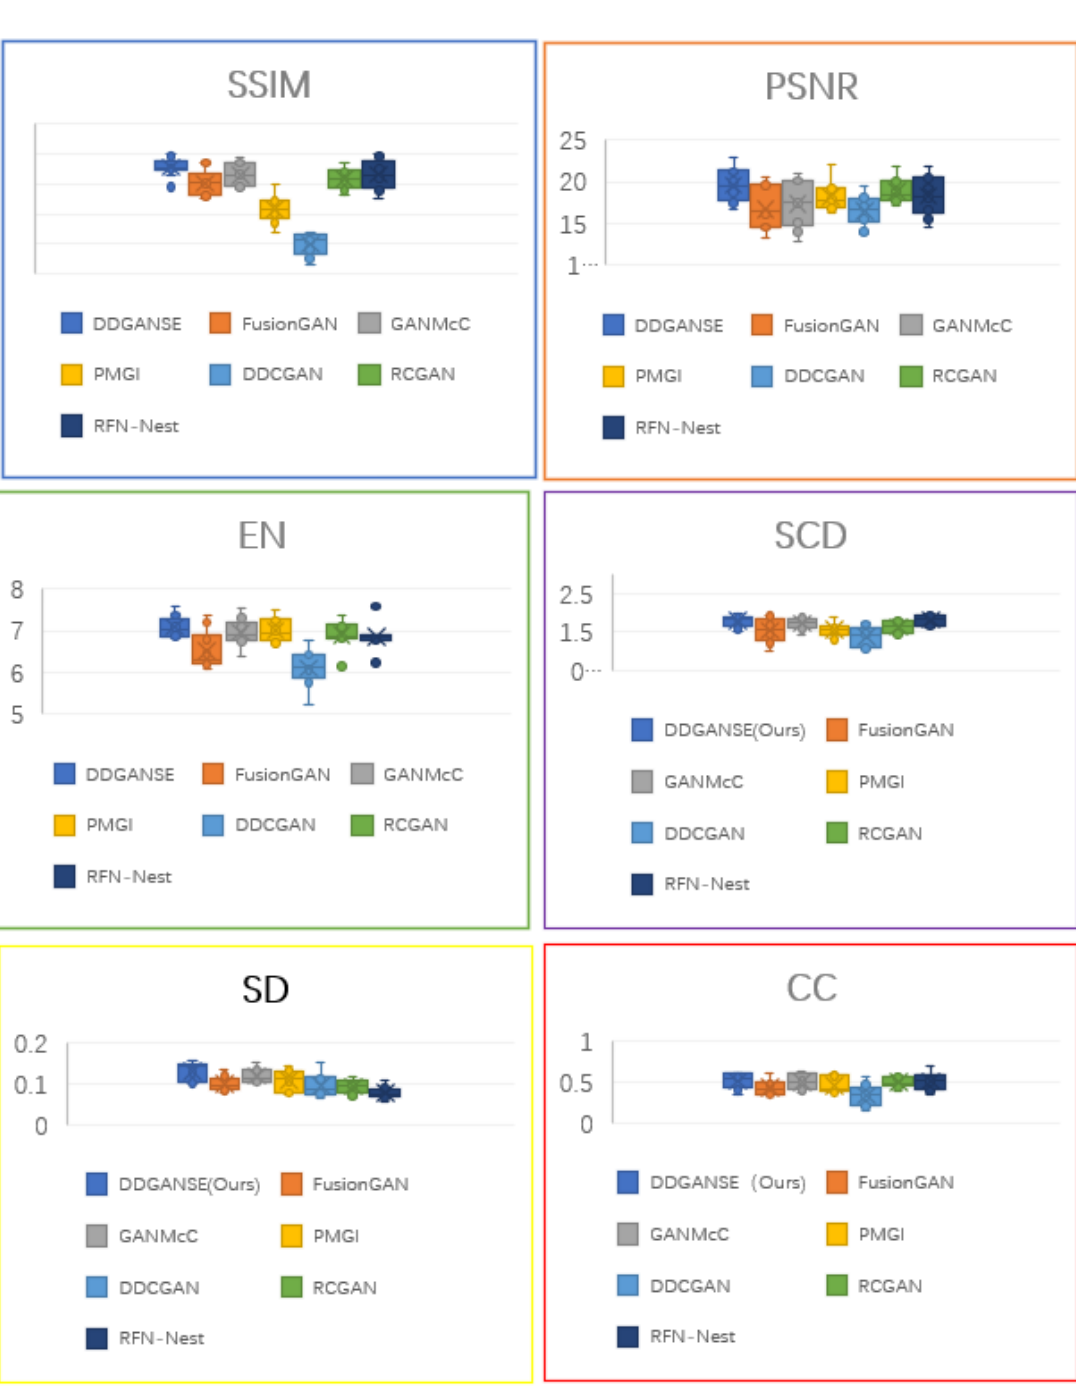
Figure 8. Box charts of the quantitative results for six indicators of infrared and visible image fusion.